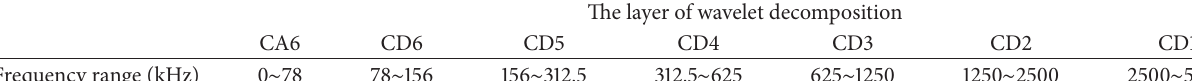
Figure 7: Fracture patterns for the four types of rock specimens. Table 2: The distribution of the frequency band in each layer.